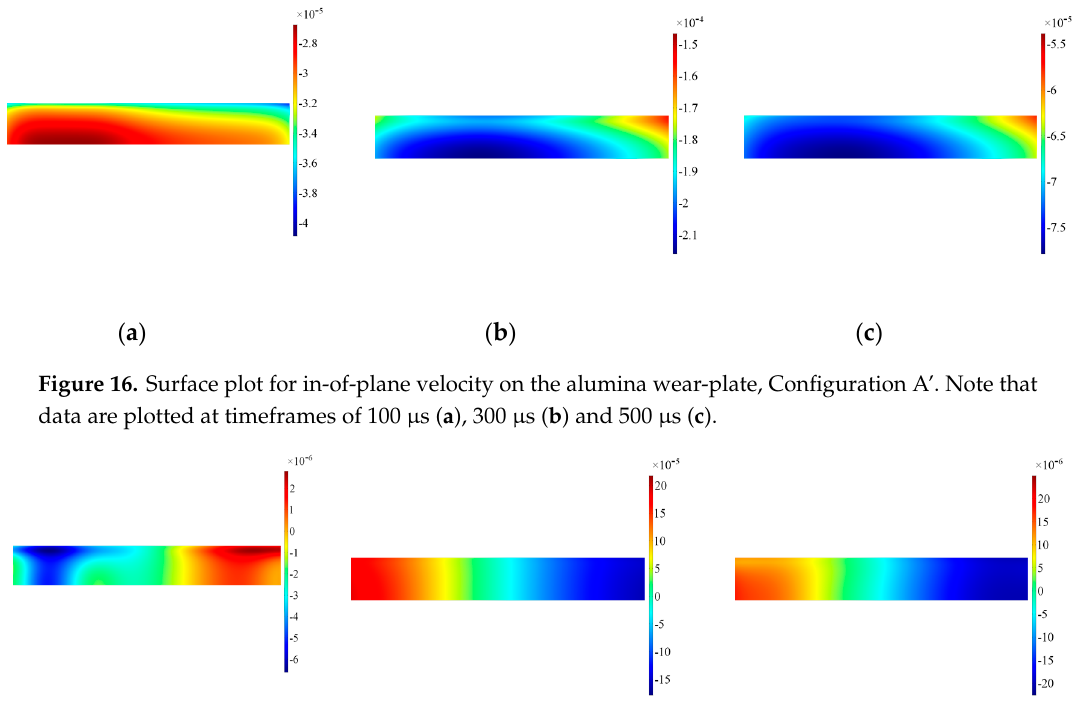
Figure 15. Configuration A’ results of the in-plane (blue), ‘S’, and out-of-plane, ‘N’, (red) velocities along the line orthogonal to the line of vibration. Normalized data are shown.